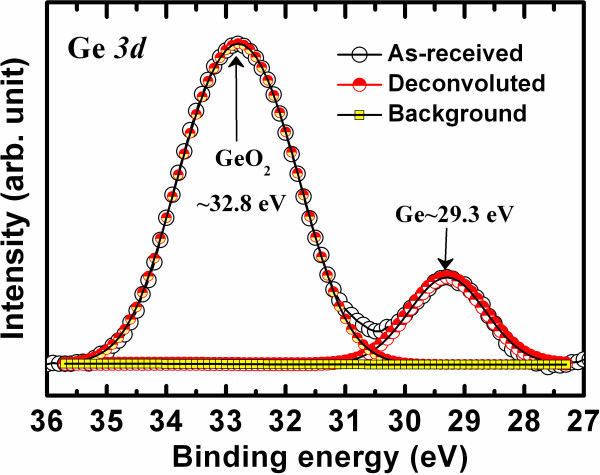
XPS spectra of Ge 3d core-level electrons of the Ge/GeOx NWs.